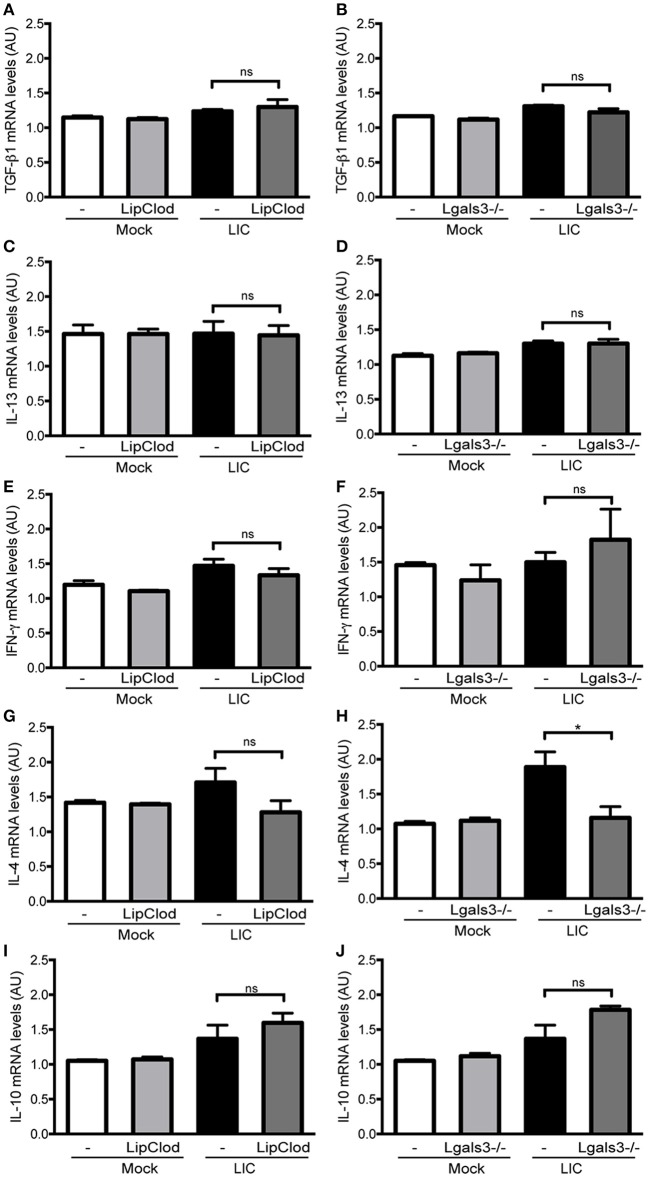
Cytokine mRNA levels in renal interstitial fibrosis triggered by LIC infection showing that fibrosis was not associated with TGF-β1 or IL-13 mRNA levels in the kidney. qRT-PCR analysis of TGF-β1 (A,B), IL-13 (C,D), IFN-γ (E,F), IL-4 (G,H), and IL-10 (I,J) mRNA levels in kidney samples from LIC, LIC + LipClod, and LIC + Lgals3−/− groups of mice at 45 dpi. β-actin was used as a housekeeping control. Data represent assays of two independent experiments of groups of 6 animals, each; AU, arbitrary units; nsP > 0.05; *P < 0.05.